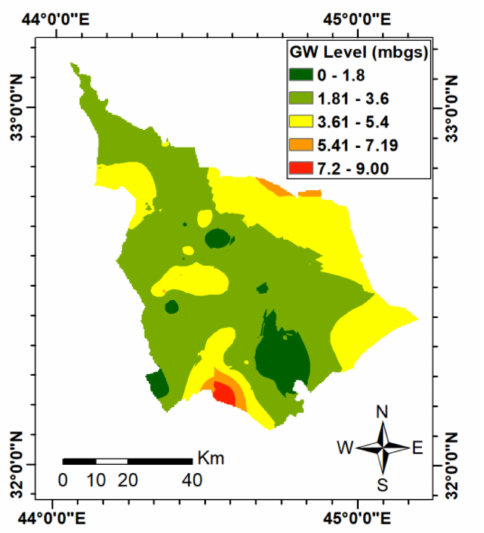
Figure 3. Groundwater table depth within Babylon study area (meters below the ground surface, m.b.g.s.)